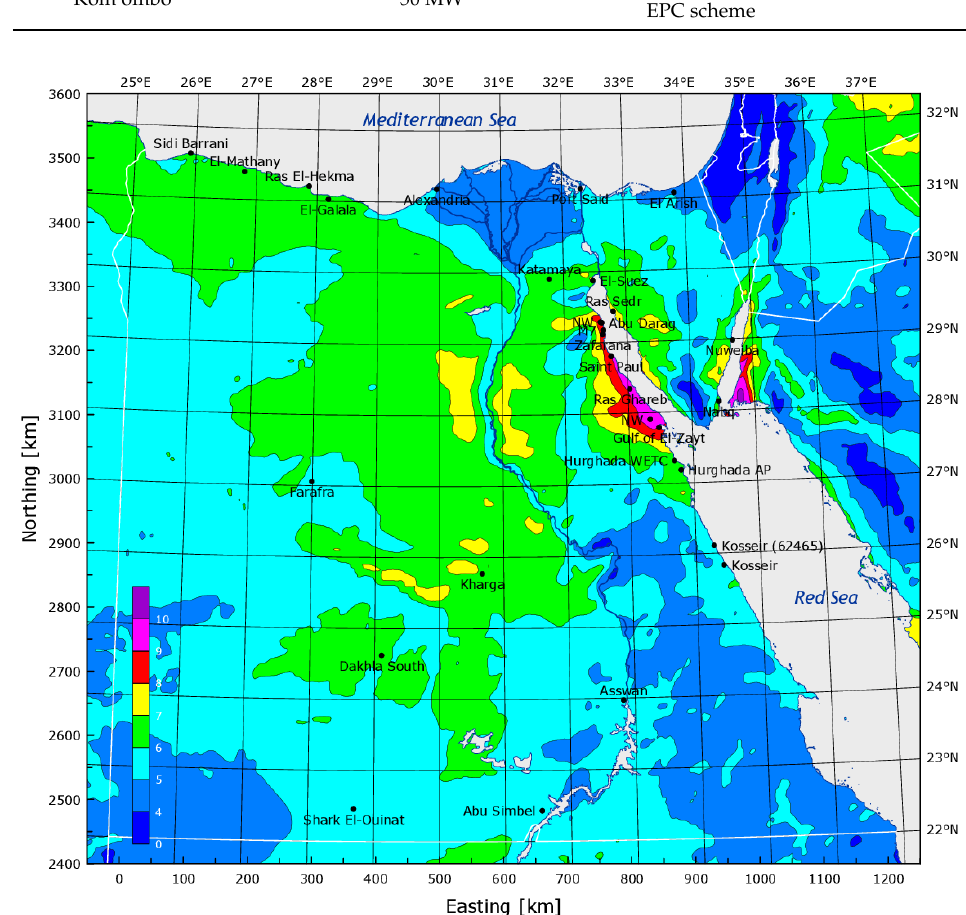
Figure 12. Wind Atlas of Egypt.